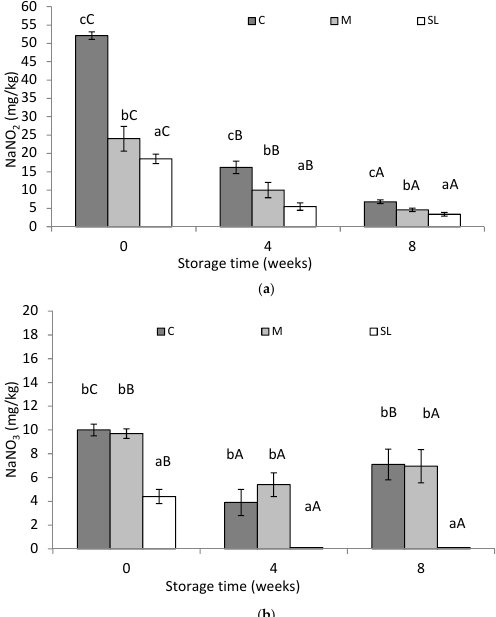
Figure 1. Means (bars) and SD (line segments) of residual nitrites ( a ) and nitrates ( b ) in model meat products during storage. a–c: means with different letters differ significantly among treat- ments ( p < 0.05); A–C: means with different letters differ significantly among timepoints ( p < 0.05). C—control treatment with NaNO 2 in an amount of 100 mg/kg; M—treatment with NaNO 2 in an amount of 50 mg/kg; SL—treatment with NaNO 2 in an amount of 50 mg/kg and L. fermentum S8 at about 10 7 cfu/g, and S. carnosus ATCC 51365 at about 10 7 cfu/g. LAB are relatively anaerobic bacteria. In unfavourable conditions, LAB may use ox- ygen as a terminal electron acceptor. One of the products occurring due to oxygen reduc- tion by bacteria within the respiratory chain strongly oxidises hydrogen peroxide (H 2 O 2 ) [29,30]. H 2 O 2 is toxic also for bacteria itself and is usually quickly secreted into the envi- ronment [31]. H 2 O 2 produced by bacteria in raw meat batter could have an effect on higher redox potential value in SL treatment after cooking compared to other variants. Pyruvic acid is an intermediate product of each of the carbohydrates’ metabolism processes of Lactobacillus bacteria. This chemical compound plays the role of an electron acceptor, but it also enables keeping oxidation and reduction balance in the cell [32]. This acid could occur in the product after cooking and have an effect on redox potential stability in the SL variant during storage.